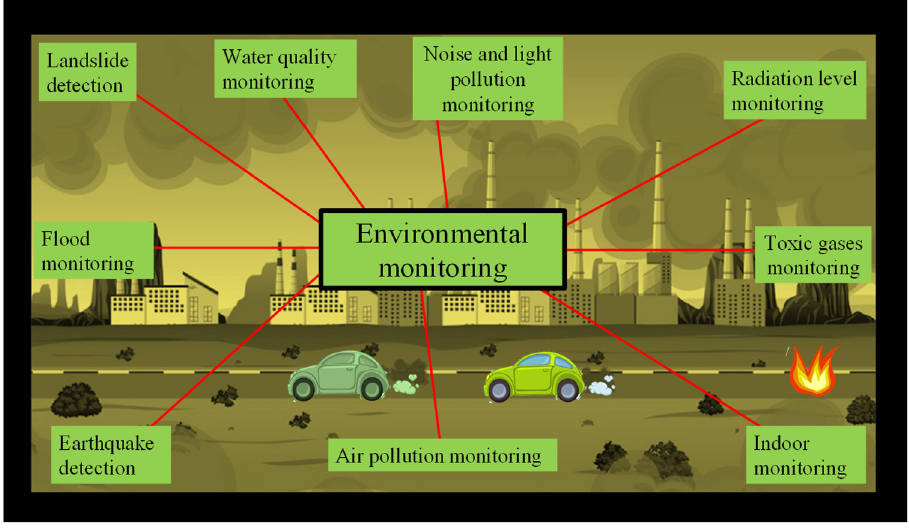
Figure 2. The environmental monitoring applications.